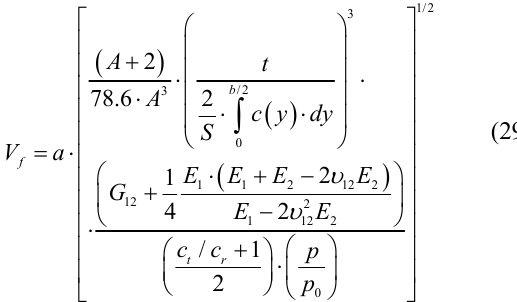
Table 3: Isotropic material Coefficients C tip / C root